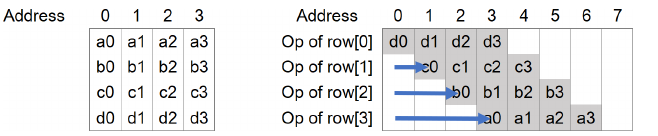
ˆ H L ( s = 4). Each column represents a